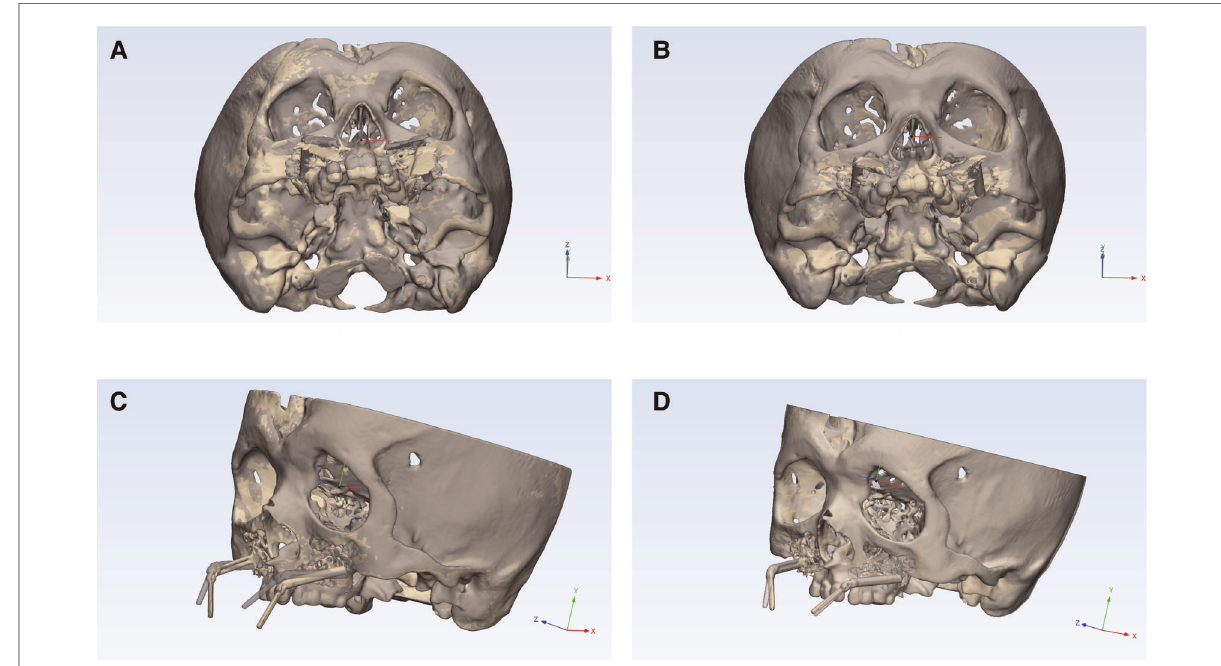
FIGURE 5 Outcome evaluation note: ( A ) Pre-bending group ’ s distractor vector and position evaluation. ( B ) AR+Pre-bending group ’ s distractor vector and position evaluation. ( C ) Pre-bending group ’ s distraction result evaluation. ( D ) AR+Pre-bending group ’ s distraction result evaluation. The post- operative skull model (yellow and opaque) was registered to the planned skull to assess the accuracy of the distractor vector and position ( A, B ), as well as the distraction result ( C, D